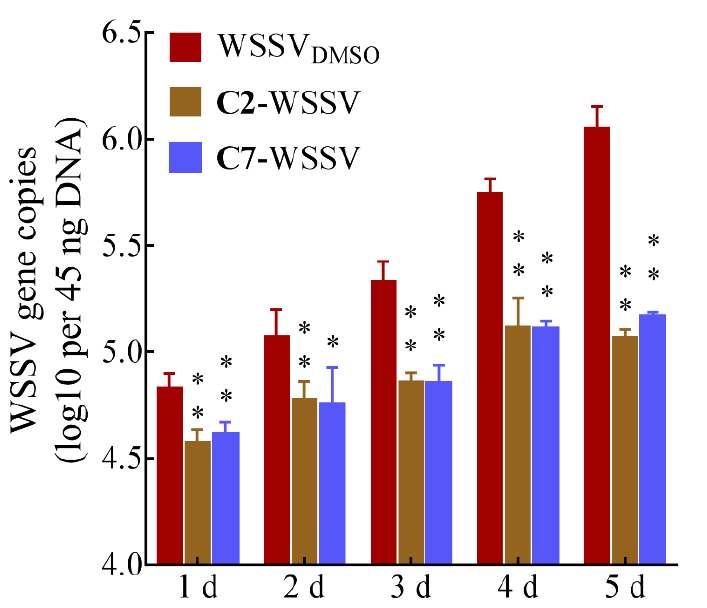
Figure 7. Inhibition of C2 and C7 on WSSV horizontal transmission. Each value is represented as the mean ± SD normalized to values for no treatment. The p value for each study was determined by Student’s t tests. ** p < 0.01; * p < 0.05.